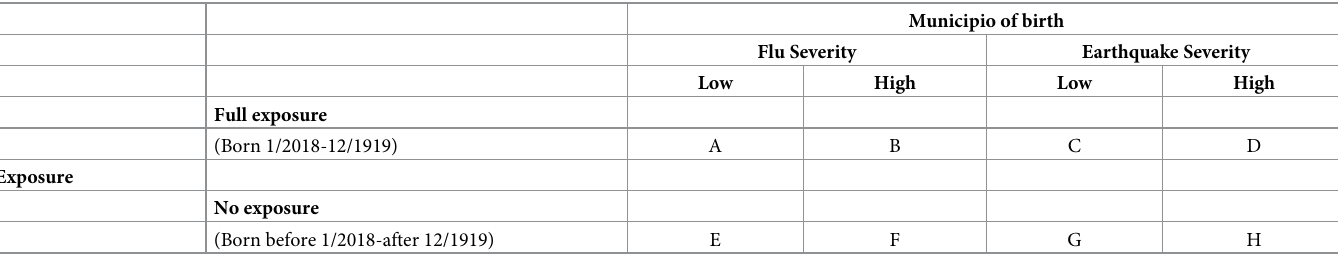
Table 1. Stylized representation of study